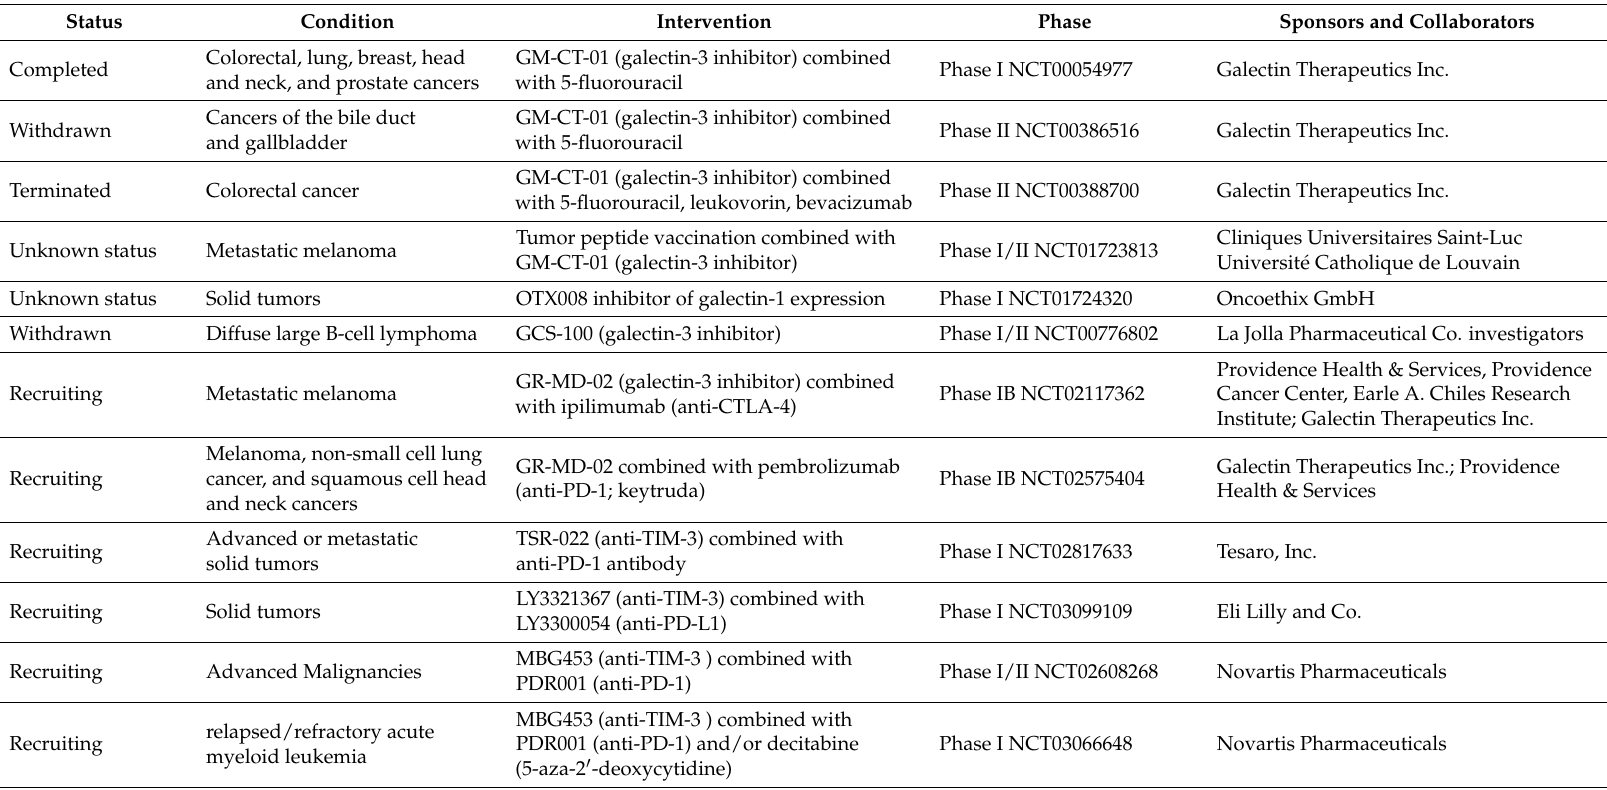
Table 2. Targeting galectins and their ligands in clinical